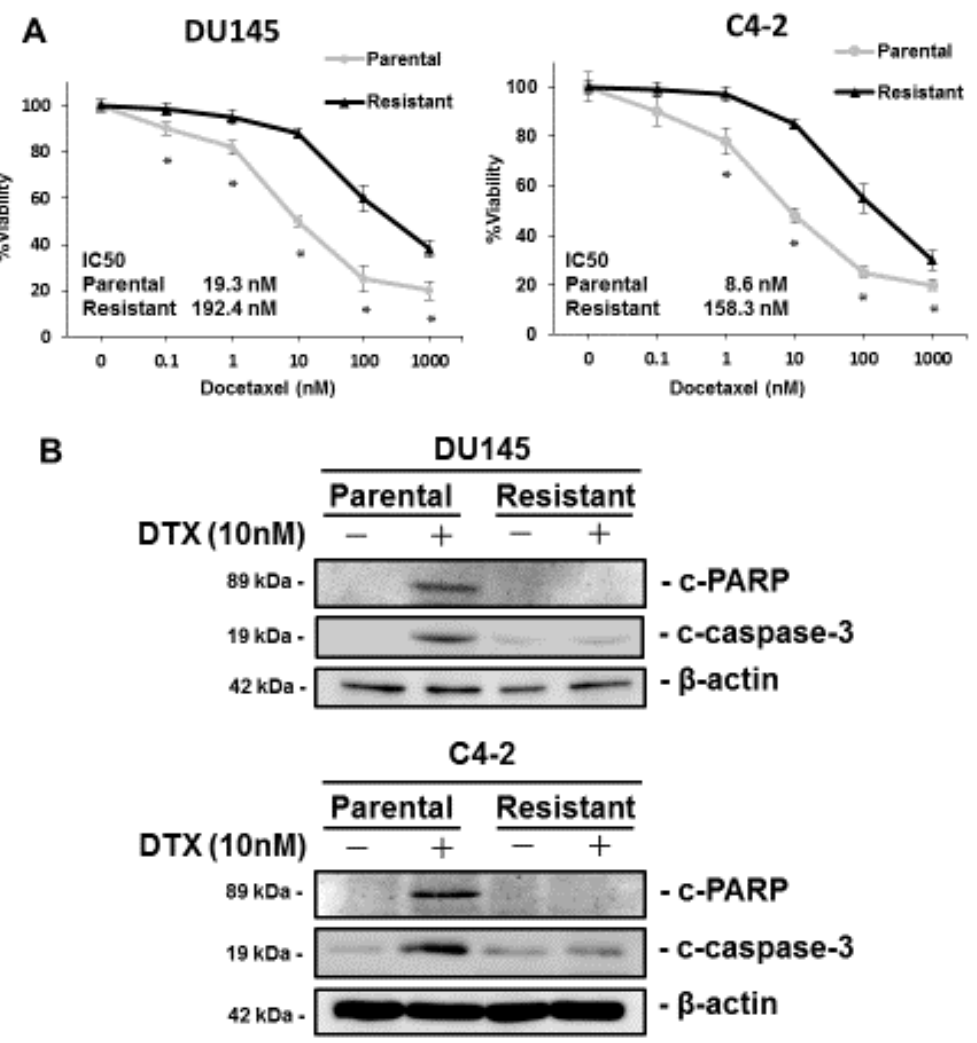
Figure 1. Characterization of docetaxel (DTX)-resistant prostate cancer cell lines. ( A ) The dose-dependent effects of DTX on the viability of parental and DTX-resistant cell lines in DU145 and C4-2 cells. The results are expressed as the mean and S.D. of triplicate measurements. * p < 0.01. ( B ) Western blotting of c-PARP and c-caspase-3 in parental and DTX-resistant cell lines in DU145 and C4-2 cells in the presence of DTX (10 nM) or vehicle (ethanol). β-actin was used as a loading control. c-PARP: cleaved PARP; c-caspase-3: cleaved caspase-3.